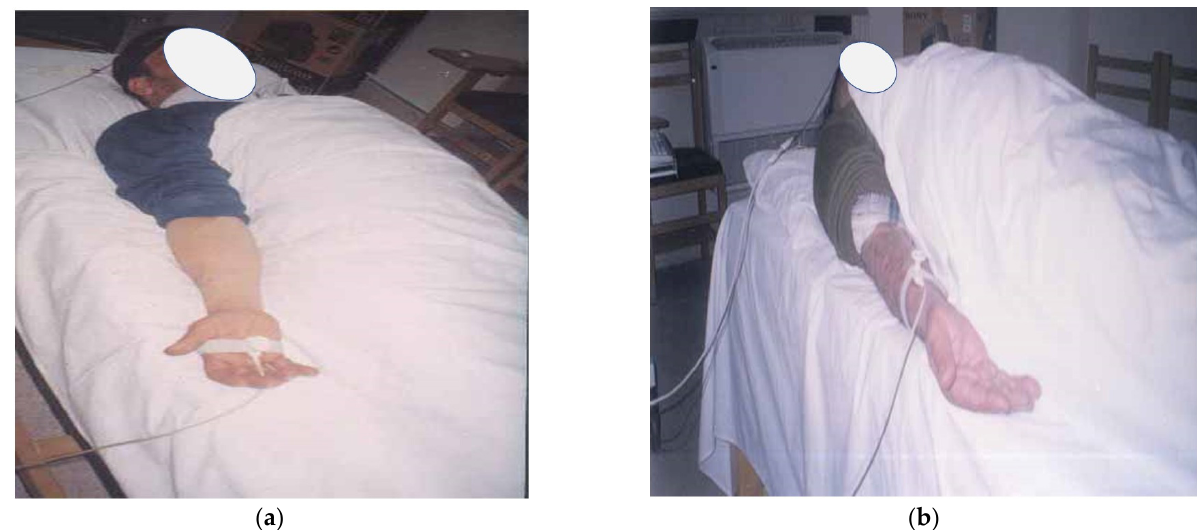
Figure 2. Location of stimulation sites indicated by arrow ( a ) for the C7 dermatome and ( b ) for the C6 dermatome.